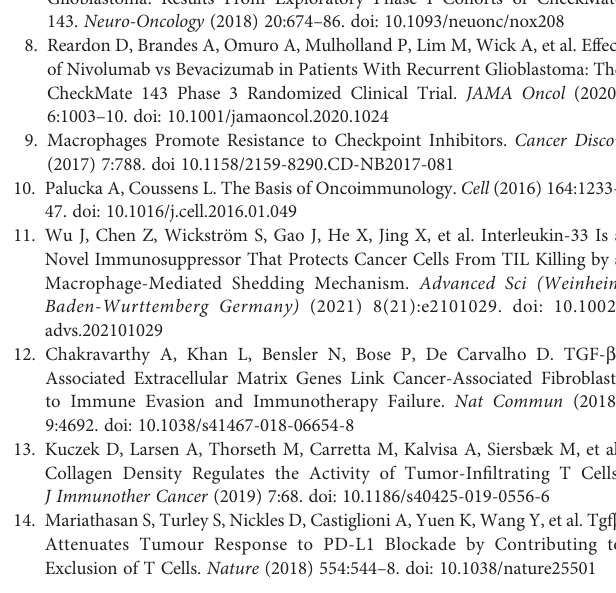
Supplementary Figure 1 | The value of risk scores in predicting prognosis. (A-C) Boxplot showed the expression of S100A4, EMP3, and PLAUR between primary and recurrent subgroups in the CGGA #693 cohort. (D) Boxplot showed that recurrent gliomas had higher risk scores relative to primary gliomas in the CGGA #693 cohort. (E) Kaplan-Meier curve displayed prognostic differences between primary and recurrent subgroups in the CGGA #693 cohort. (F) Kaplan-Meier curves displayed prognostic differences between high- and low-risk groups in primary and (G) recurrent gliomas, respectively. *, p< 0.05; **, p< 0.01; ***, p< 0.001, ****, p< 0.0001. Supplementary Table 1 | Clinical information on the gliomas involved in this